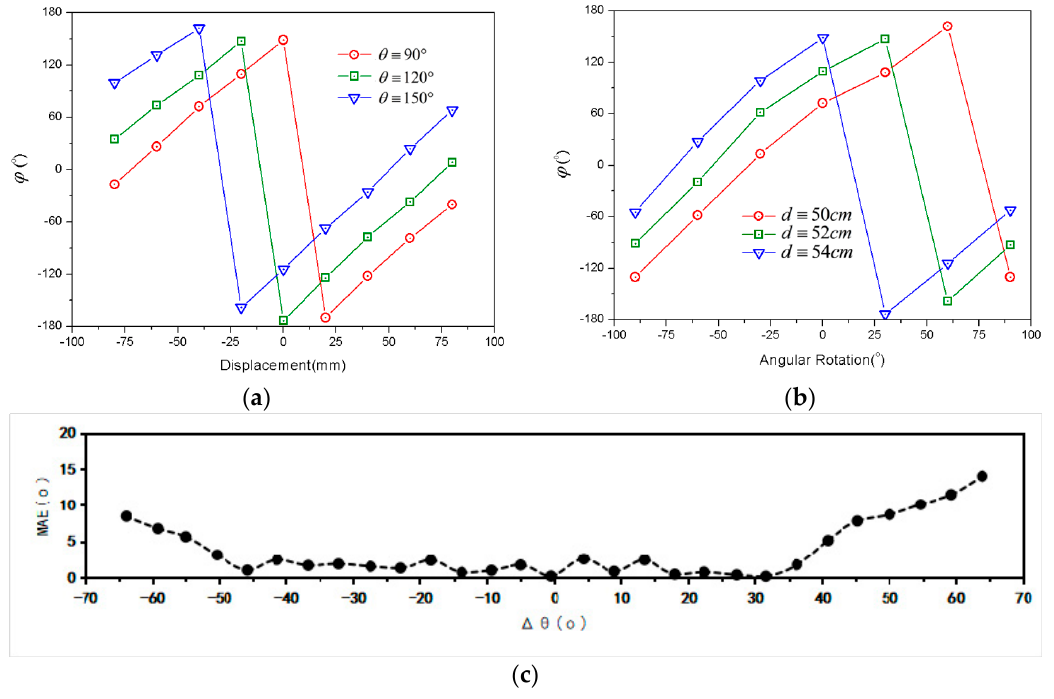
Figure 10. Experimental results with different limitation conditions: ( a ) Displacement curves with different tilt limitations; ( b ) Angular curves with different position limitations; ( c ) MAE result between measured and calculated estimate for ∆ θ .